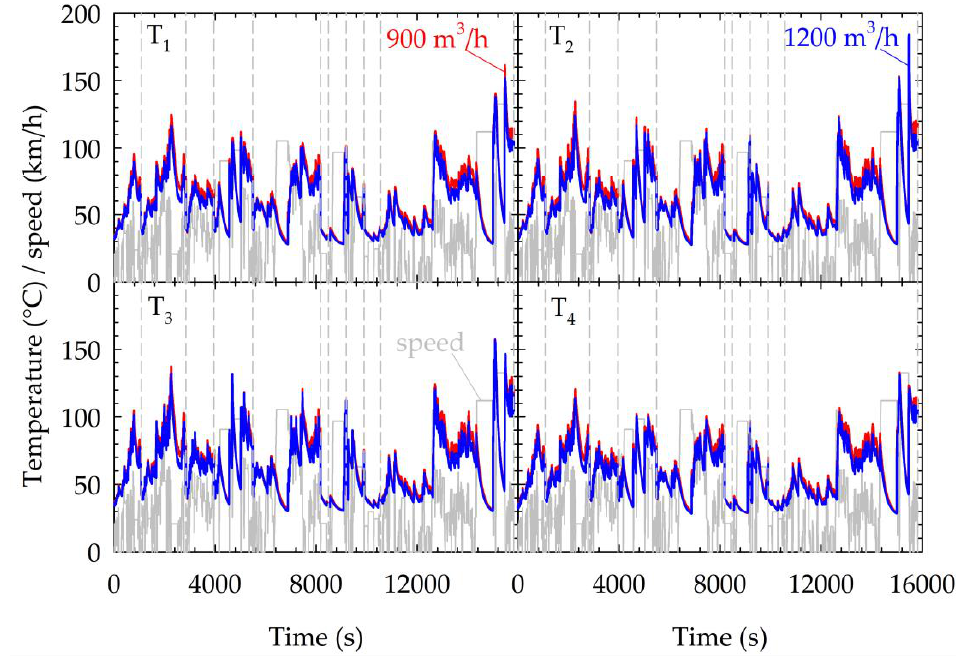
Figure A1. Speed (grey lines) and average temperature traces at 900 m 3 /h (red lines) and 1200 m 3 /h (blue lines) tunnel flow recorded with each of the 4 thermocouples over the WLTP-Brake test cycle. Dashed vertical lines are used to separate the 10 sections (trips) of the cycle.